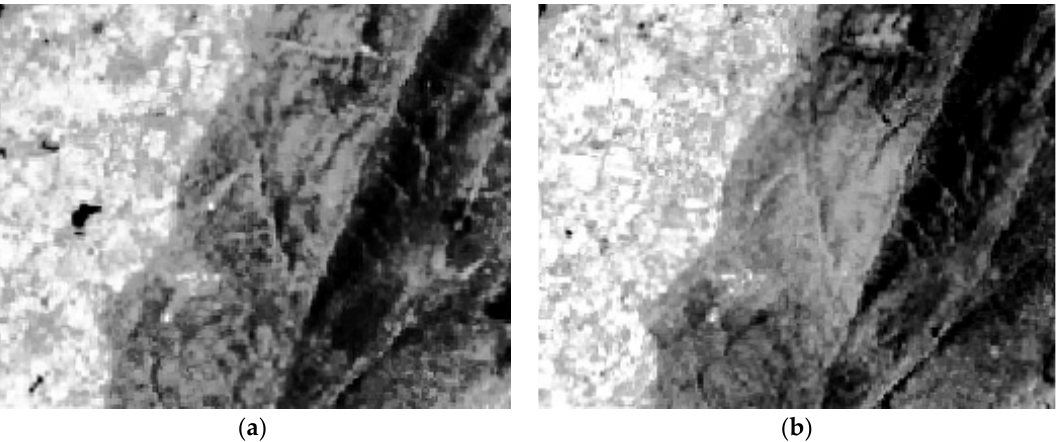
Figure 4. Preprocessed Landsat RED bands of Javadi Hill for the years ( a ) 2012 and ( b ) 2015.